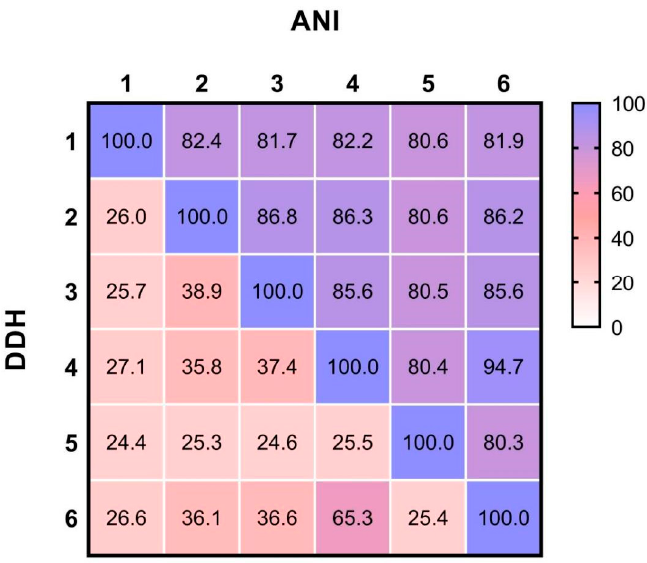
Figure 3. Heatmap of DDH and ANI percentages between strain N23 and its closely related type strains of genus Variovorax . Strain 1, Variovorax sp. strain N23; 2, V. boronicumulans NBRC 103145 T ; 3, V. guangxiensis DSM 27352 T ; 4, V. paradoxus NBRC 15149 T ; 5, V. soli NBRC 106424 T ; 6, V. beijingensis 502 T .